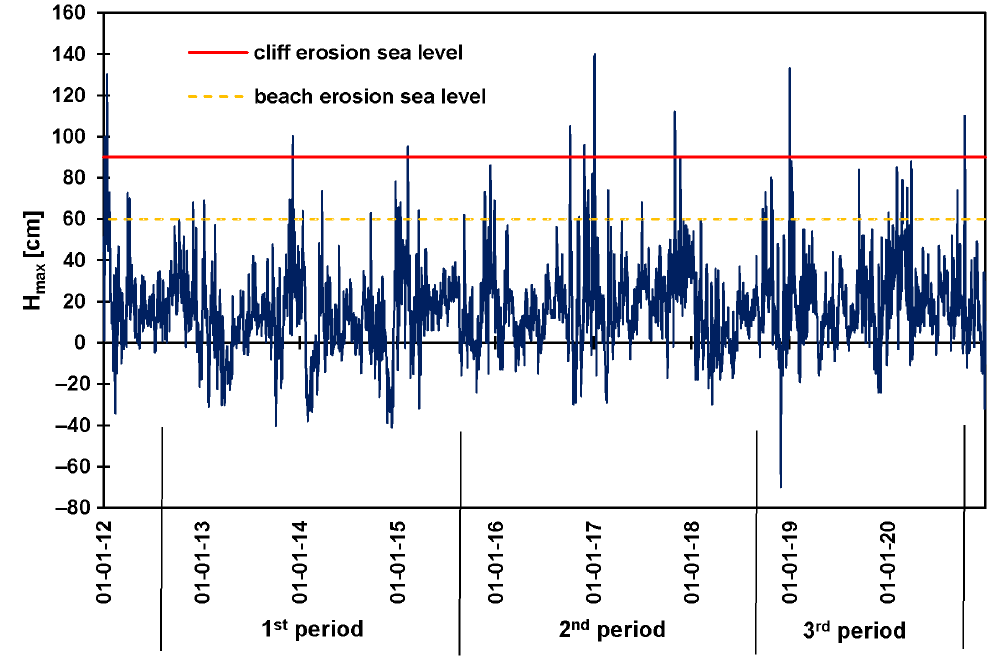
Figure 4. Maximum sea level in the research period ( Ś winouj ś cie—N.N. reference level). Raw data source—Institute of Meteorology and Water Management.